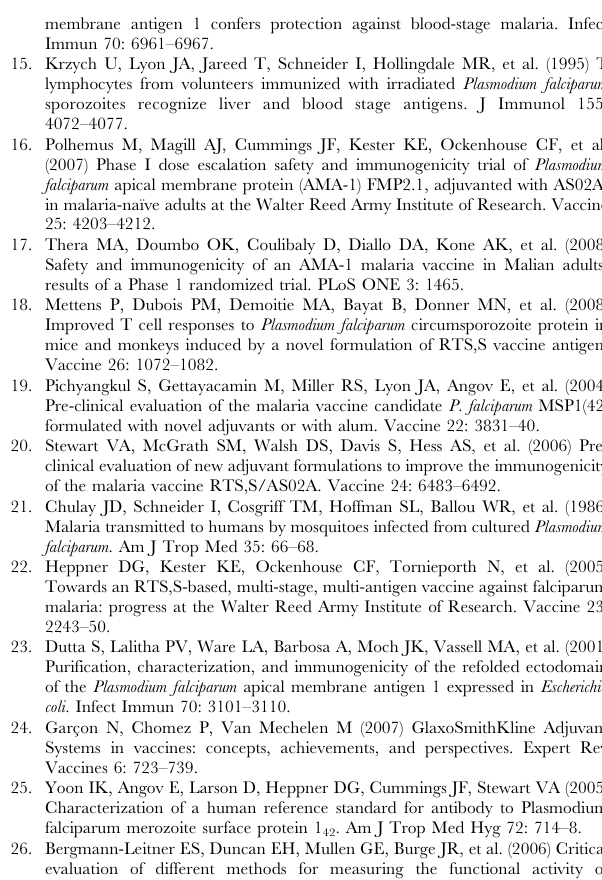
Protocol S1 Trial protocol. Phase I/IIa double-blind, random- ized study of the safety, immunogenicity and preliminary efficacy after primary sporozoite challenge of FMP2.1/AS01B and FMP2.1/AS02A candidate malaria